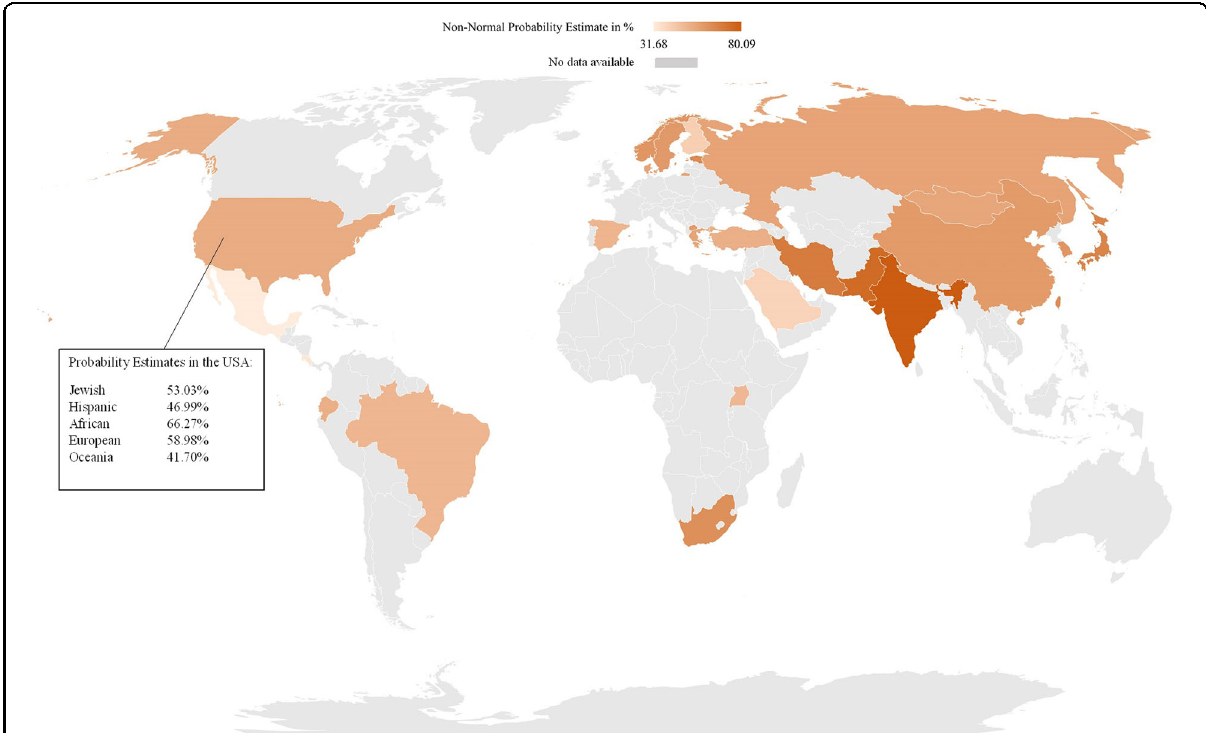
Fig. 5 Worldwide CYP2C19 non-normal metabolizer probability